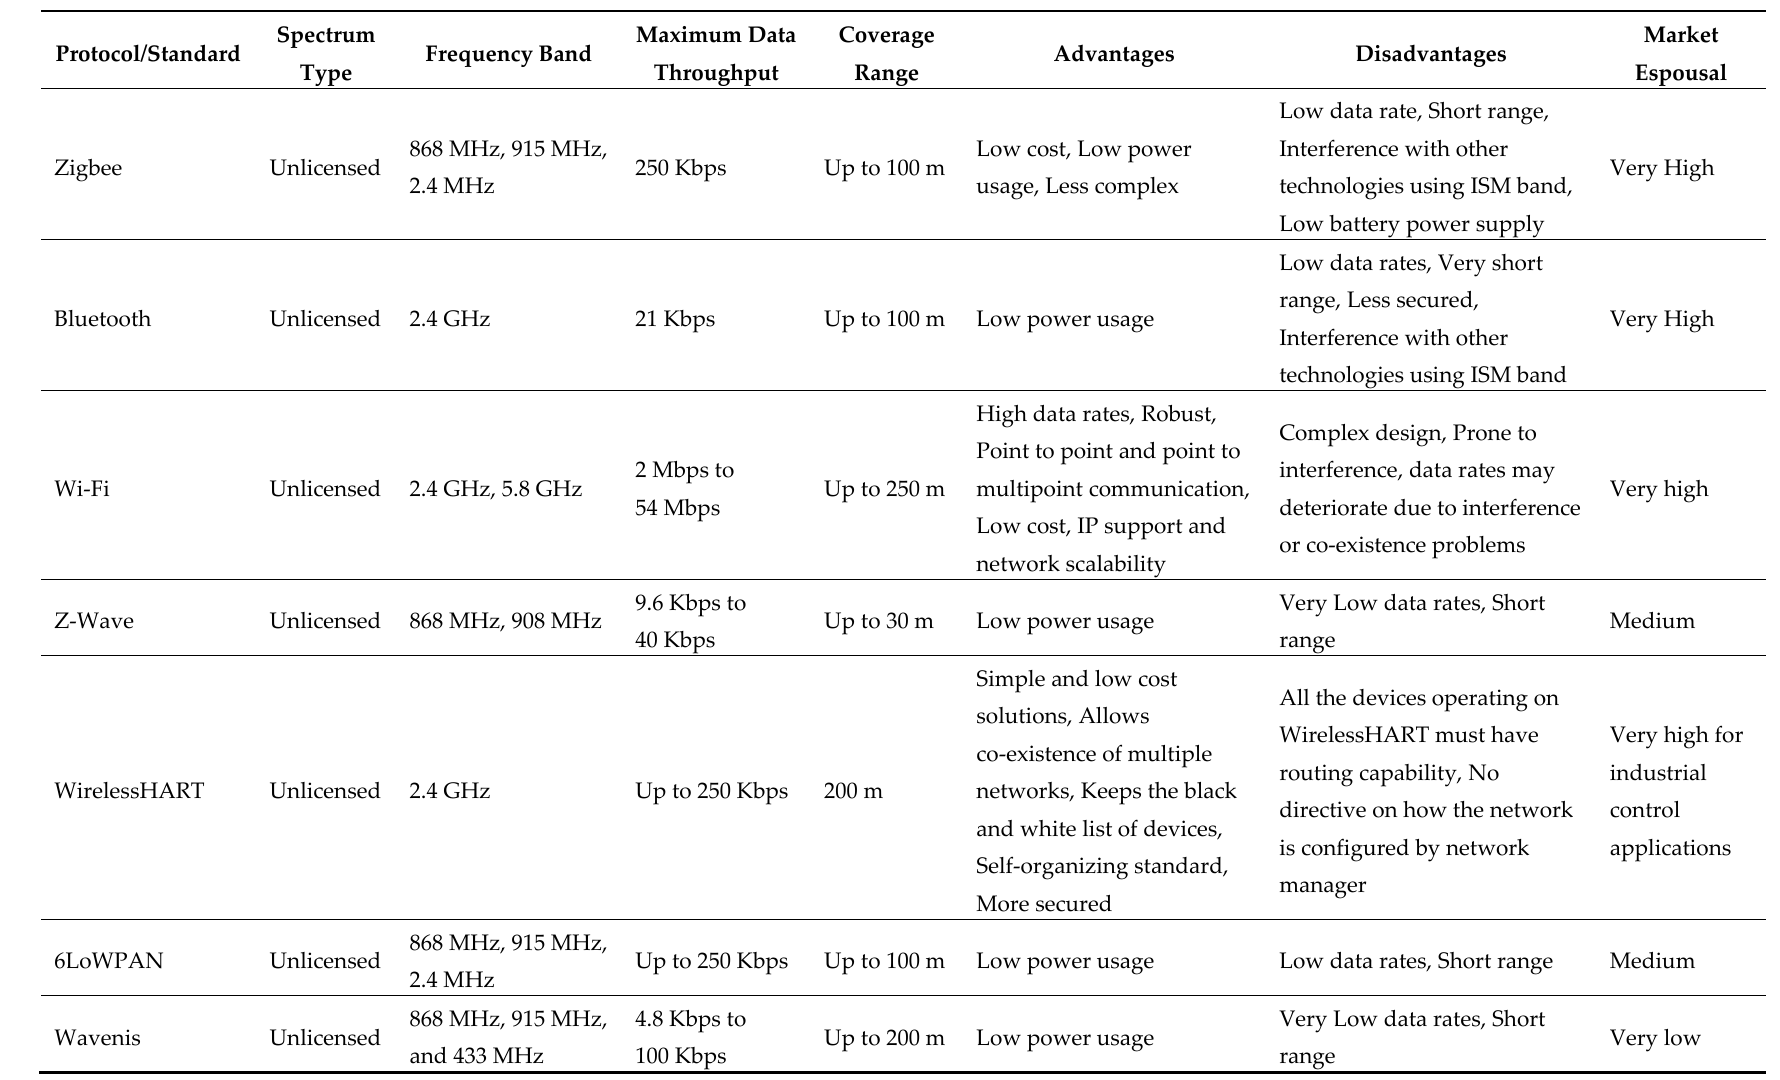
Table 2. Comparative analysis of various communication standards for WSN (Wireless Sensor